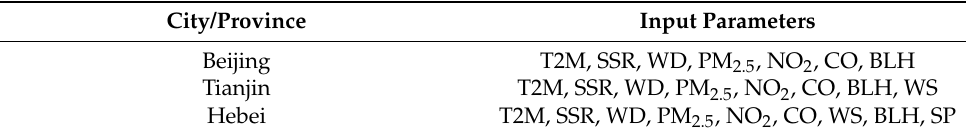
Table 5. Input parameters for ANN in Beijing, Tianjin and Hebei province.